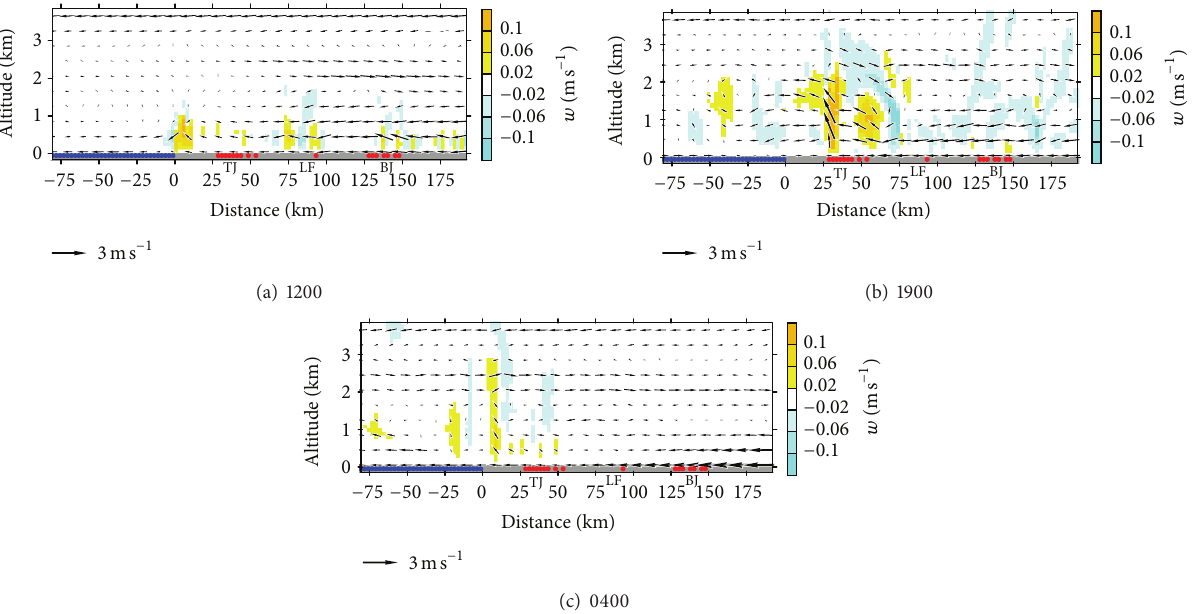
Figure 7: Similar to Figure 6, but for the FLAT experiment. (a) 1200LST 24 August, (b) 1900LST 24 August, and (c) 0400 LST 25 August. The three cities from left to right are Tianjin (TJ), Langfang (LF), and Beijing (BJ), respectively. Please refer to Figure 6 for more details of the figure